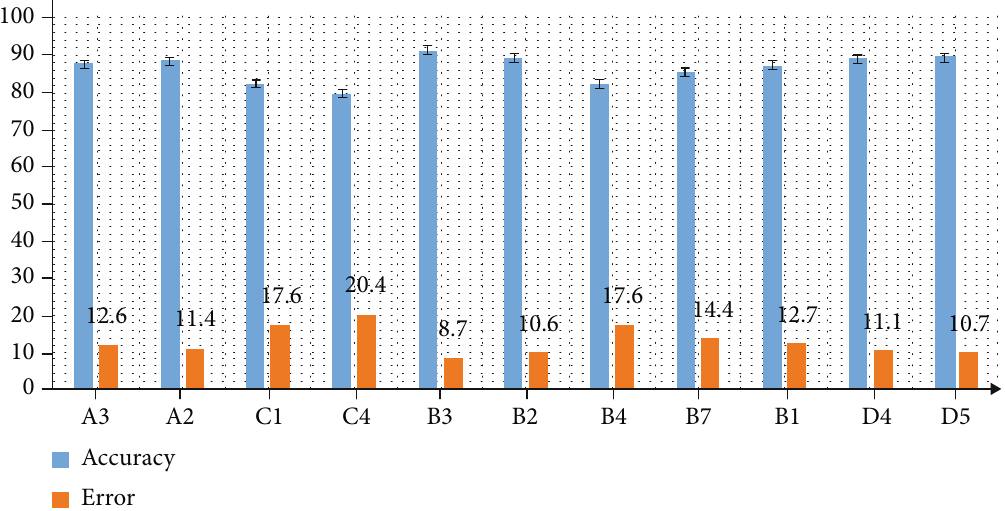
Figure 4: Accuracy and error analysis.